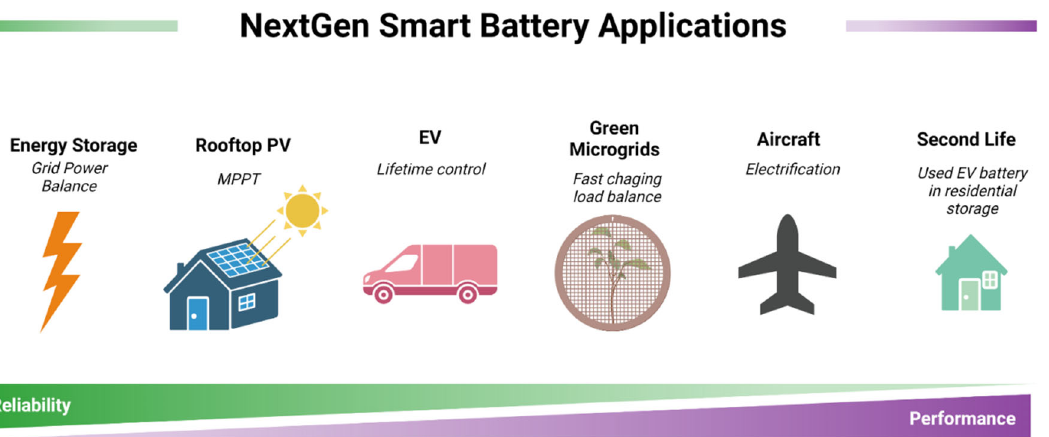
15 of 17 Figure 14. A detailed overview of the Smart Battery system with various attributes including opti ‐ mization of SOX (SOP, SOE, SOT, and SOH). Based on whether the performance is optimized or not, the bypass switches act to activate or provide rest to a cell. The cell aging model is built on AI trained neural network blocks that fully emulate a real battery aging mechanism for given user load profiles and desired performance with a given aging condition of the battery as the initial state of operation. 7. Applications of the Smart Battery A natural question that arises regards the contribution of Smart Batteries to the field of power and energy systems, which spans many directions as shown in Figure 15. Start ‐ ing from energy storage in power grids to maximum power point tracking in solar pho ‐ tovoltaics, the Smart Battery widely covers the generation, transmission, and distribution sectors of electrical energy. Vehicle ‐ to ‐ grid is an upcoming industry and is anticipated to be limited by battery cycling and aging constraints, but with the Smart Battery, this can be effectively overcome. With green transition as the target of many developing and de ‐ veloped nations, transportation electrification for rail, road, and airways is being investi ‐ gated. This requires electric vehicles to have reliable, high ‐ performing, and long ‐ lasting batteries, requirements that are the core fundamentals on which the Smart Battery is de ‐ signed. One major challenge in the EV industry is the rising fast charging industry, which is known to degrade batteries and accelerate their aging. With lifetime extension as a key